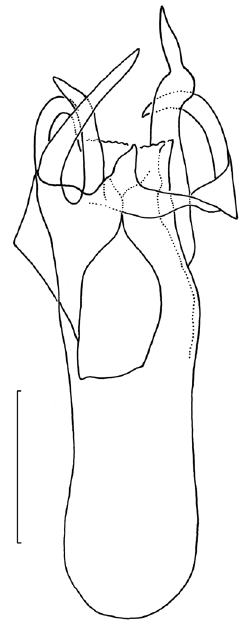
Figure 149. Acalyptris janzeni , phallus, holotype. Scale: 100